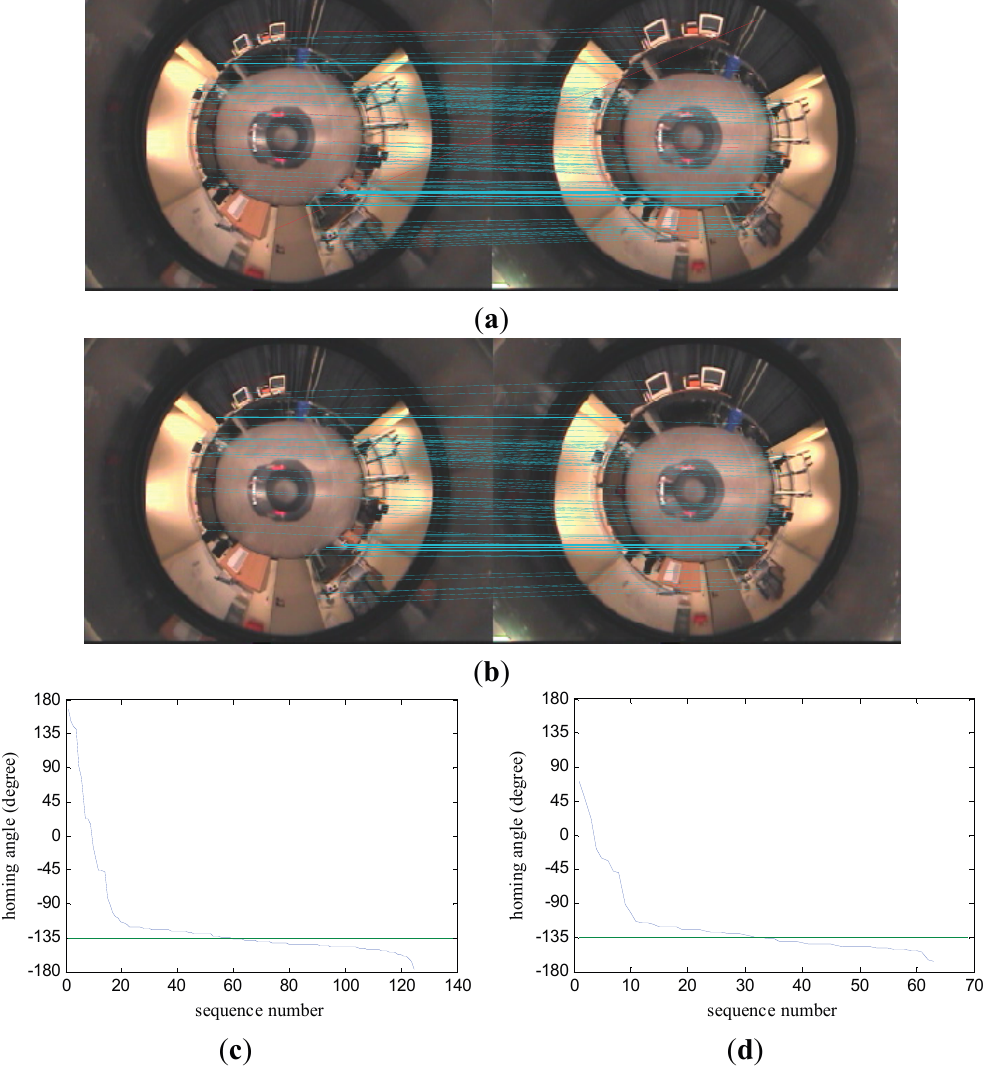
Figure 4. The performance of the proposed mismatching elimination algorithm. ( a ) The matching of landmarks before mismatching elimination; ( b ) the matching of landmarks after mismatching elimination; ( c , d ) the distribution of homing angles computed by the proposed homing algorithm before and after mismatching